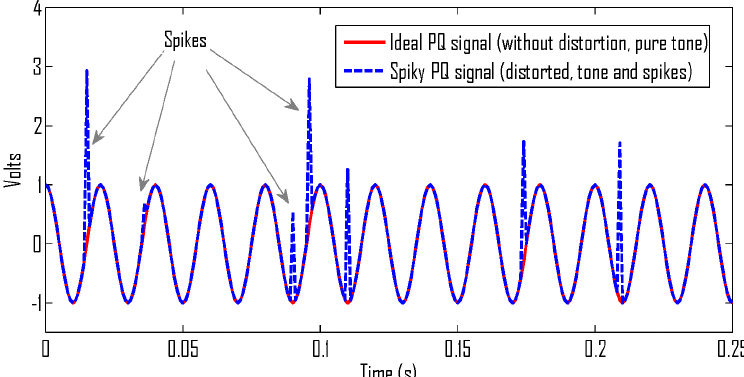
Figure 1. A synthetic power quality signal having both tones and